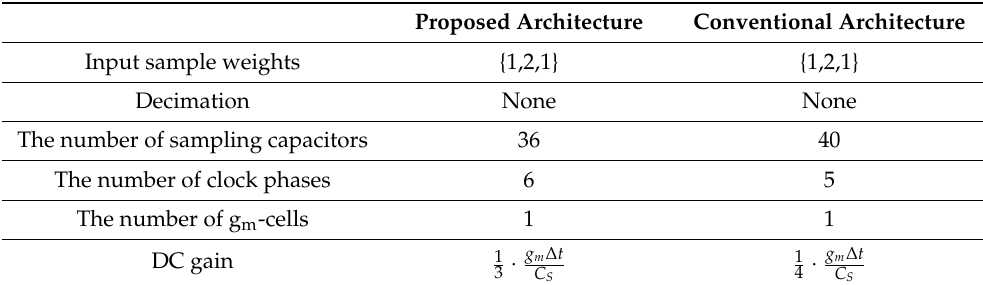
Table 3. Performance comparison between the proposed and conventional architectures.